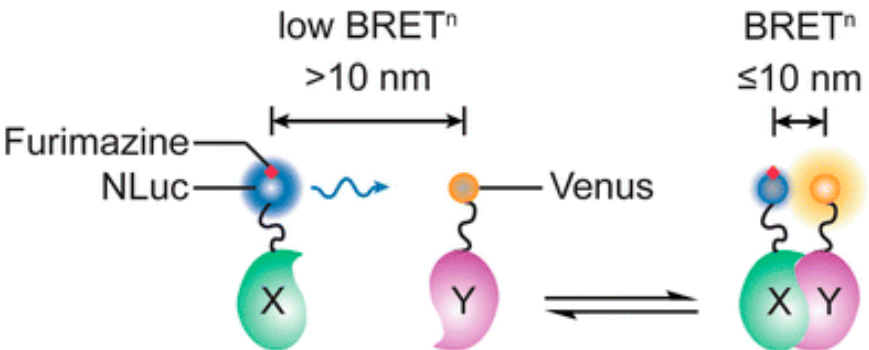
Figure 1. Schematic of a NLuc based BRET (BRET n ) design. Nluc is the donor fluorphore and Venus is the acceptor fluorophore. Nluc and Venus are fused to their respective proteins of interest (X and Y). BRET signal is detected when the proteins are in close proximity. Reprinted by permission from Springer Nature [14]. Copyright 2016.